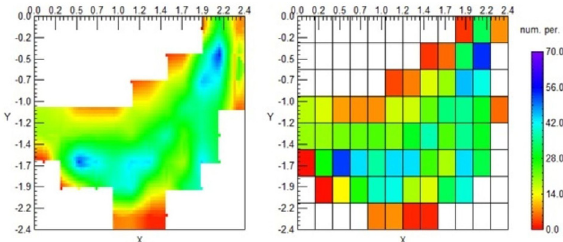
Figure 11. 3D position of the seismic tomography sensor